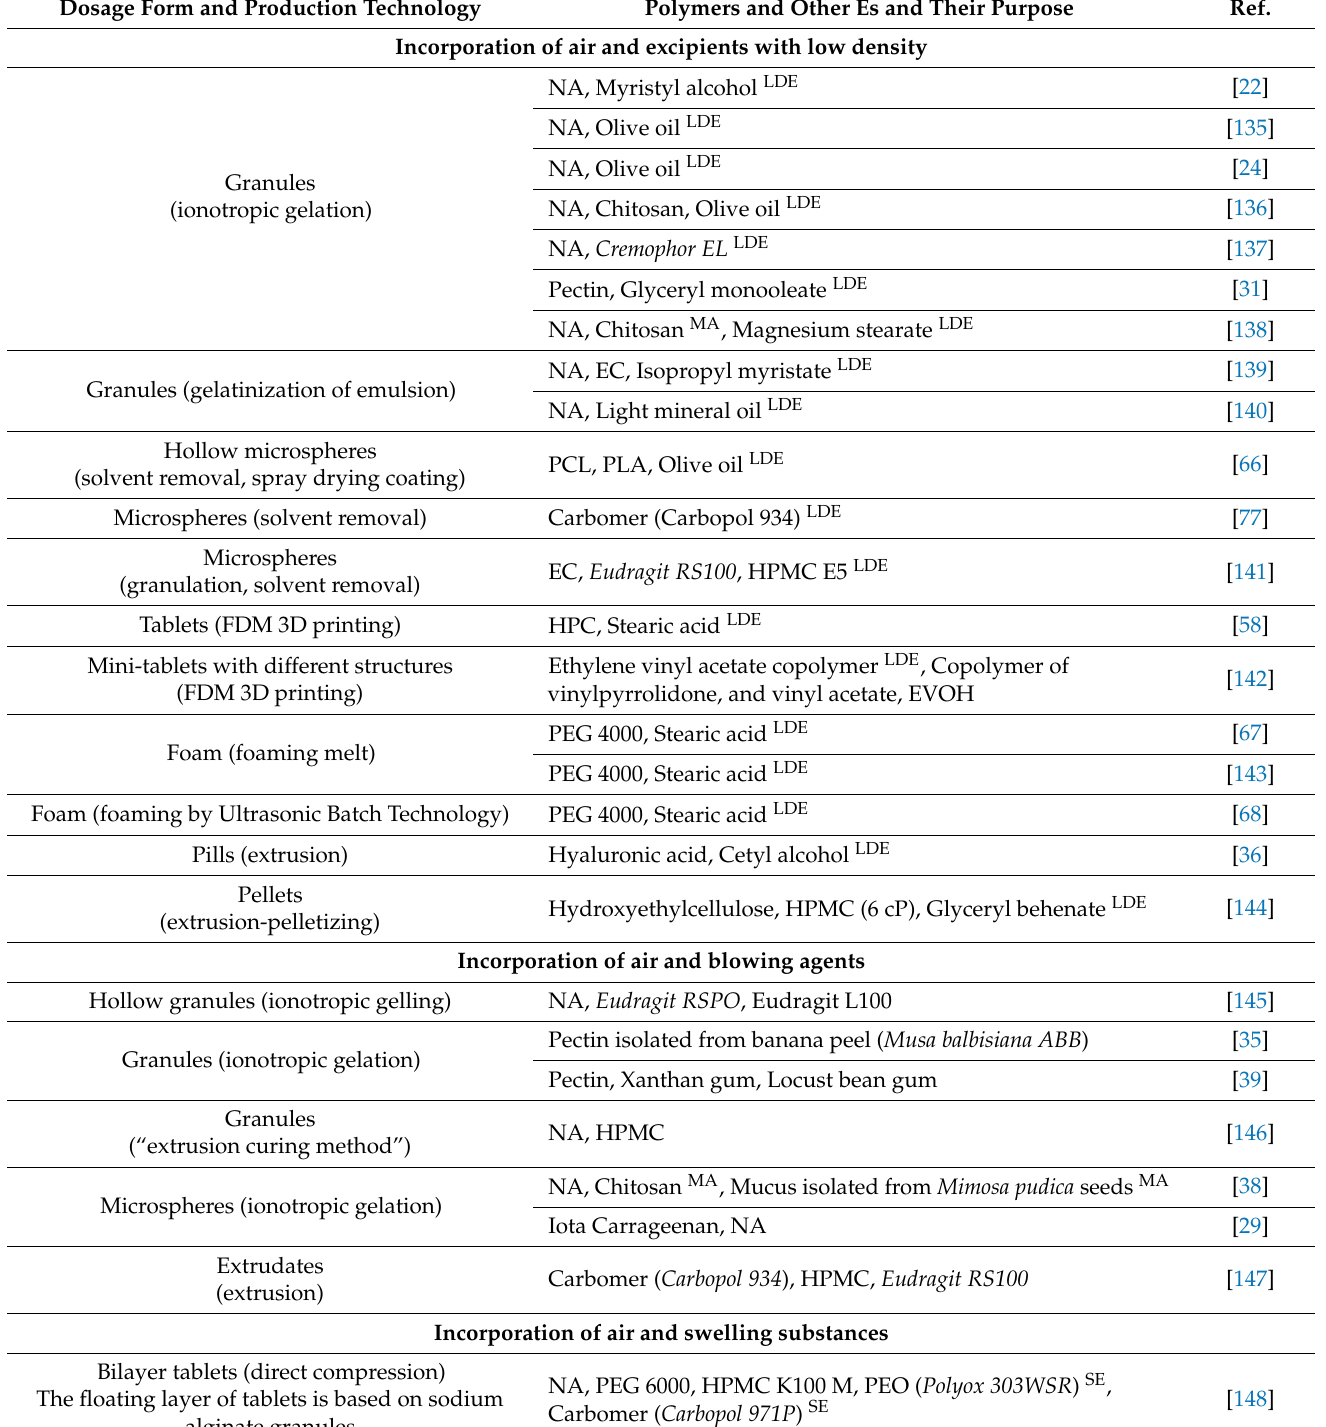
Table 2. Examples of the use of various polymers in the field of obtaining floating drug delivery systems by combining several approaches to achieve